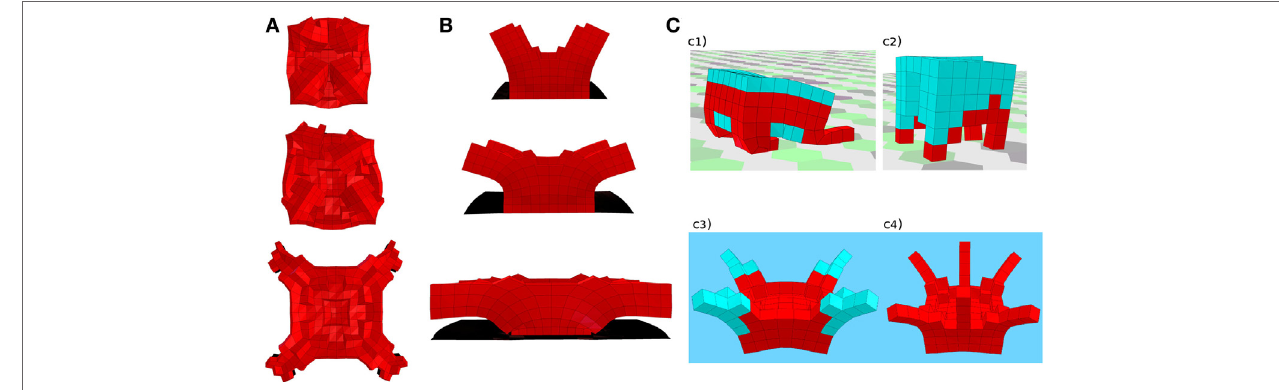
FiGUre 1 | Plant and animal-like creatures evolved by the system for different task environments. (A,B) Two sample plant-like robots, evolved to perform phototropism (see them in action here: https://youtu.be/Cw2SwPNwcfM). Red tissue expands in response to light stimuli. Different growth stages are shown as ontogenetic time unfolds from top to bottom. Both robots exploit passive dynamics and the interaction with the environment (e.g., gravity) in order to perform the task with a remarkably simple growth controller. Branching and symmetry are emergent traits. (A) Top view, four light sources (not depicted) are present at the four corners. The robot expands in response to light stimuli and unfolds under the effect of gravity, resembling a blooming flower. (B) Front view, two lateral light sources (not depicted) are present. A perfect self-sustained cantilevered structure can be noted, where the curvature needed to point toward the lateral light sources is achieved passively. Results of this study suggest that taking into account compliance and material properties is of paramount importance in order to evolve effective plant-like creatures exploiting morphological computation. (c) Four sample animal-like robots evolved to locomote in different environments. Red voxels are volumetrically actuated through a sinusoidal open-loop signal, while light blue ones are passive. (c1,c2) Two quadrupeds evolved to walk on land. As opposed to the more sprawled posture of the soft robot in (c1), a stiffer material (c2) allows an upright position and a proper walking pattern. (c3,c4) Two jellyfish/octopus-like creatures evolved to swim in a watery environment. Video: